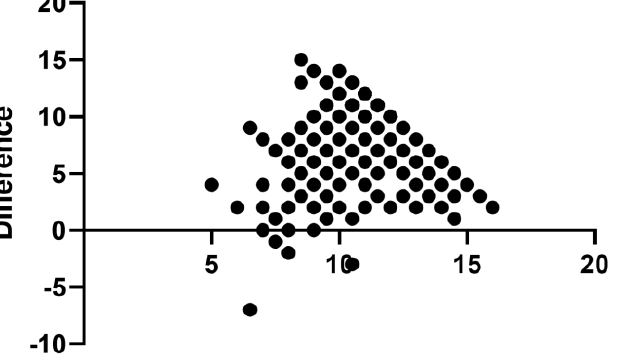
Figure 3. Bland – Altman plot depicting the difference between the SAHL and the SAEHL versus the average.